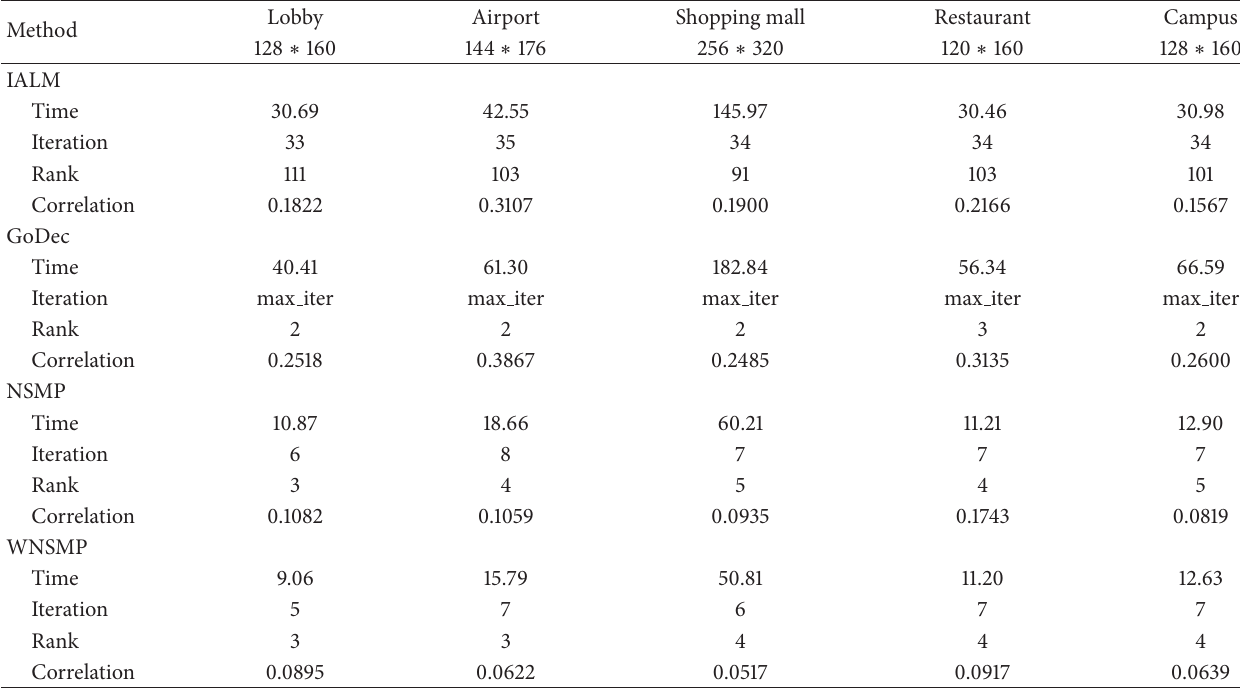
Table 1: The data comparison of background modeling and foreground